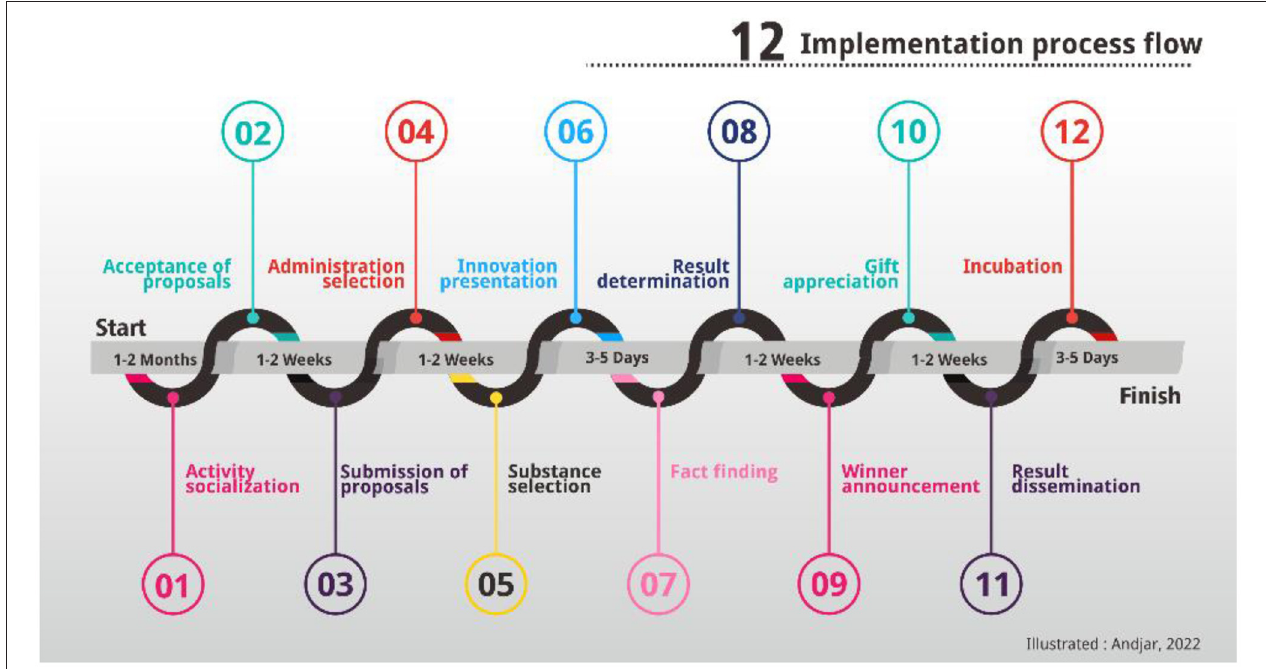
FIGURE 1 | Community innovation interaction